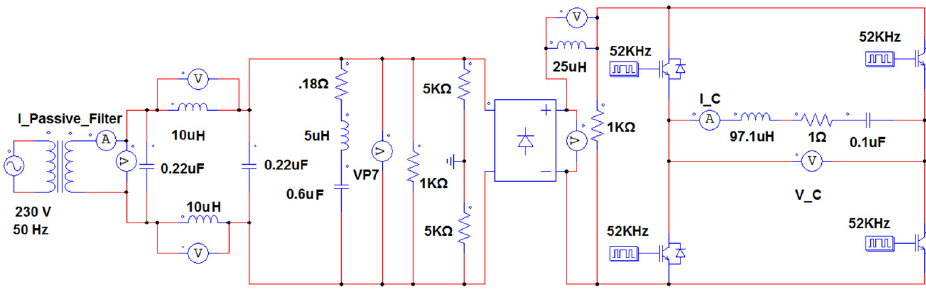
Figure 11. Simulation circuit diagram of an IH system with a passive filter.